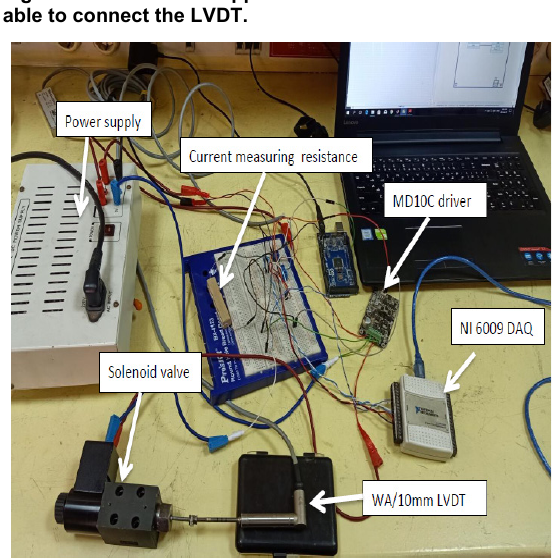
Figure 9 Experimental setup includes LVDT, power supply, driving card, and the current measuring resistance.